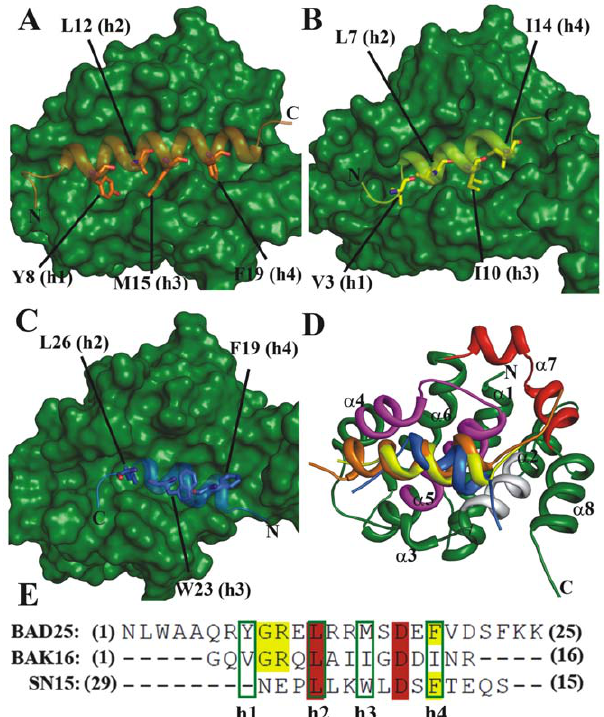
Figure 1. Binding orientation and sequence comparison of SN15 with BH3 peptides. The interaction pattern of Bcl-X L and Bad (A), Bak (B), SN15 (C) was shown. All the three peptides represented as cartoon and Bcl-X L as surface. Hydrophobic residues of the peptides which occupy the four hydrophobic pockets (p1–p4) are highlighted by sticks and labeled accordingly. All the three peptides (Bad, Bak and SN15) superimposed and the important interacting regions of Bcl-X L such as BH1, BH2 and BH3 are highlighted with magenta, red and gray, respectively (D). Shown is sequence comparison between SN15 and Bad and Bak. Four important binding points (h1–h4) are highlighted by green boxes, identical residues and conserved residues are highlighted by red and yellow colors, respectively